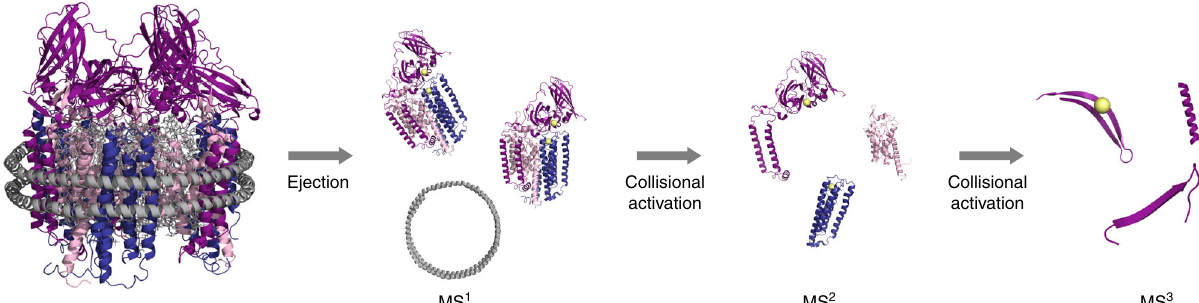
Fig. 2 The nTDMS platform for pMMO characterization. The pMMO-nanodisc complex is subjected to ejection from the nanodisc using collision-induced dissociation (CID) at the source resulting in the stabilization of the pMMO protomer species (MS 1 ). Increasing collisional activation breaks up the protomer into individual pMMO subunits (MS 2 ). Further collisional activation enables backbone fragmentation of each subunit using higher energy collisional dissociation (HCD) in the HCD cell of the instrument (MS